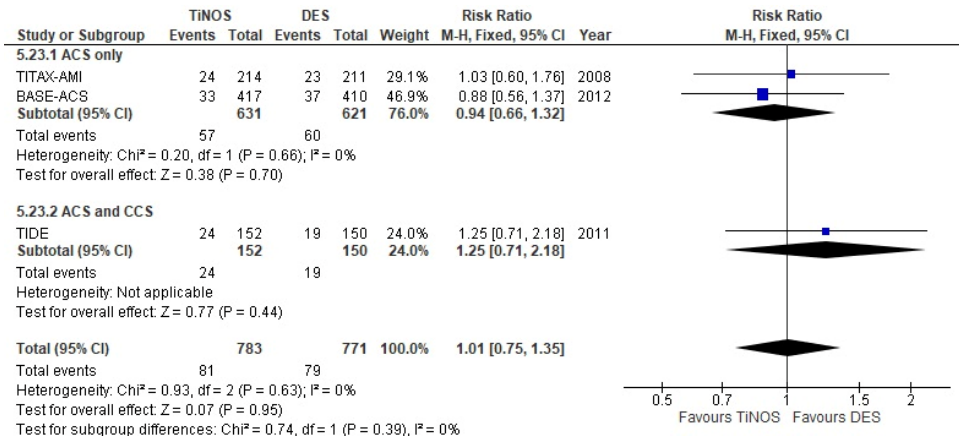
Figure 9. TLR—5 years. Table 2. Sensitivity analysis of primary and secondary